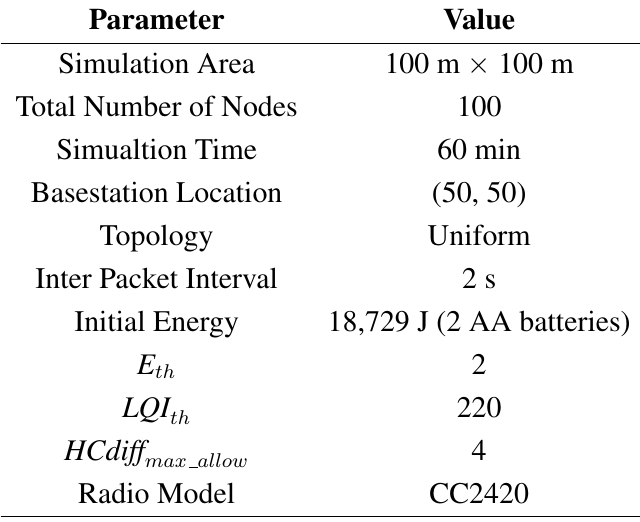
Figure 8. Simulation results of HCdiff